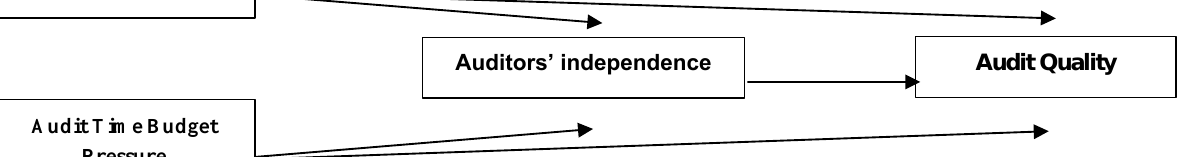
Figure 1: Conceptual